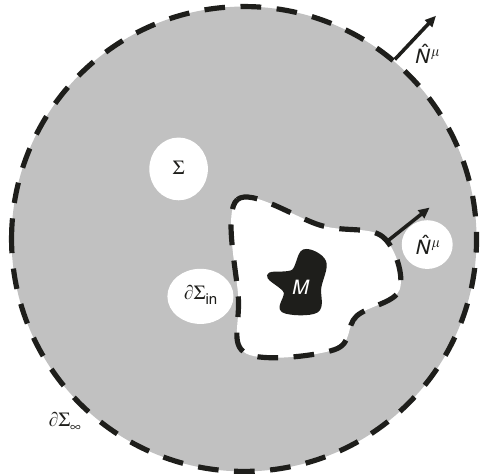
Fig. 1 Schematic of the spacelike three-dimensional hypersurface of interest, Σ , with an inner boundary ∂ Σ in and a boundary at in fi nity ∂ Σ ∞ . Here ^ N μ is the spacelike four-vector normal to the boundaries of Σ (note the direction convention on the inner boundary). We assume a general mass distribution within the inner boundary and no matter outside